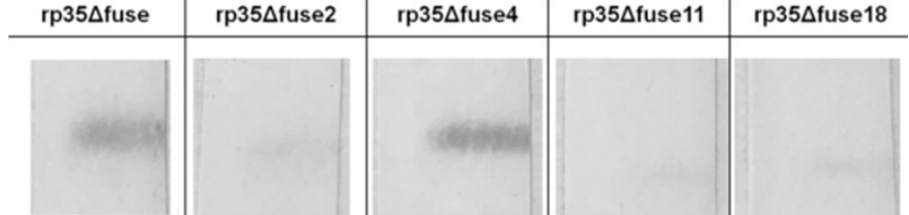
Figure 6. Characterization of mutated variants of rp35Δfuse. Western blot analysis of purified mu- tated variants of rp35Δfuse, which were fractionated by SDS-PAGE (12.5%) and developed with neutralizing pooled human sera of volunteers vaccinated with VACV (diluted to 1:200). The mutant protein rp35Δfuse4 recognized by the sera of VACV-vaccinated volun- teers was used for mice immunization, as was described in Section 2.3. The obtained anti- rp35Δfuse4 serum samples were pooled and tested for neutralizing activity against VACV in PRNT. No neutralizing activity was found (Figure 3). These data indicated that